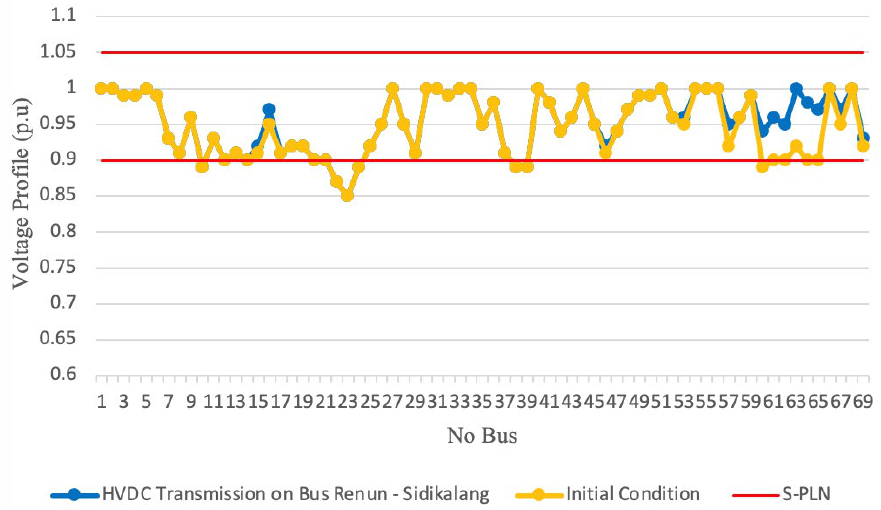
Figure 9. Voltage profile of the SUMBAGUT 150 kV transmission system after changing the Renun (Bus 66)–Sidikalang (Bus 63) to the HVDC transmission system.